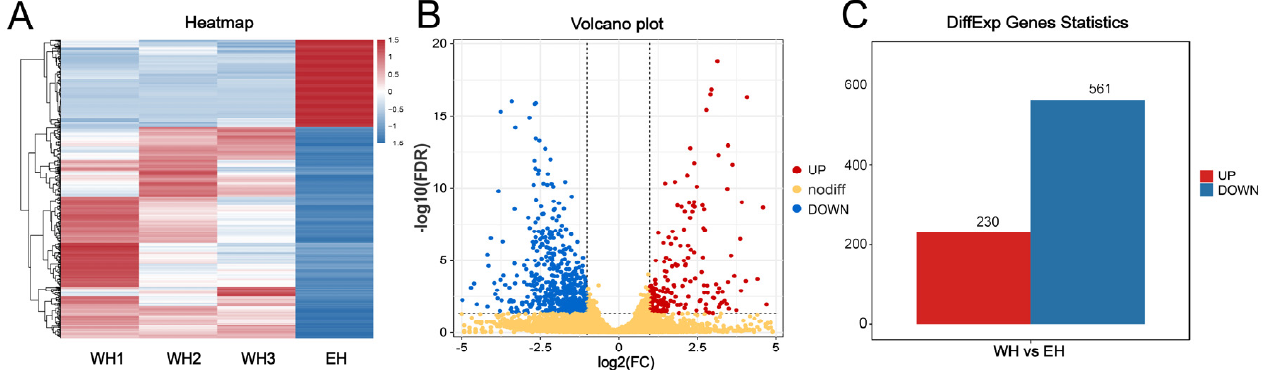
Figure 5. Sample gene expression. ( A ) Sample Correlation Heat Map. ( B ) Volcano plot of WH and EH differentially expressed genes. ( C ) Histogram of WH and EH differentially expressed